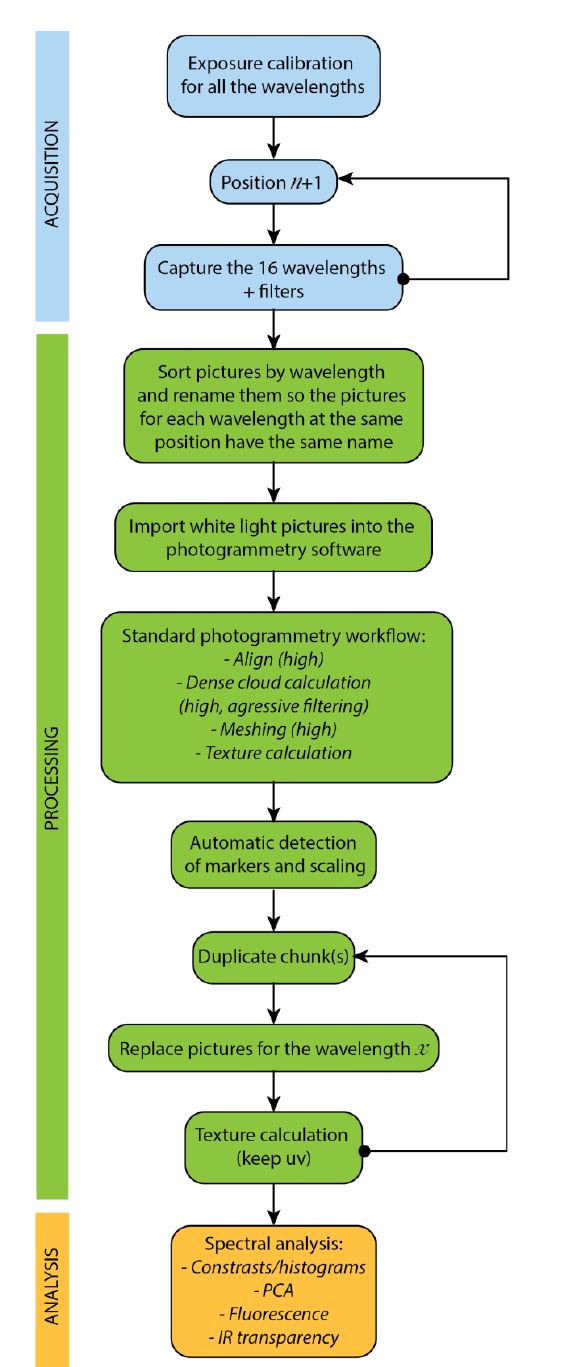
Figure 1: Theoretical workflow of data acquisition, processing and